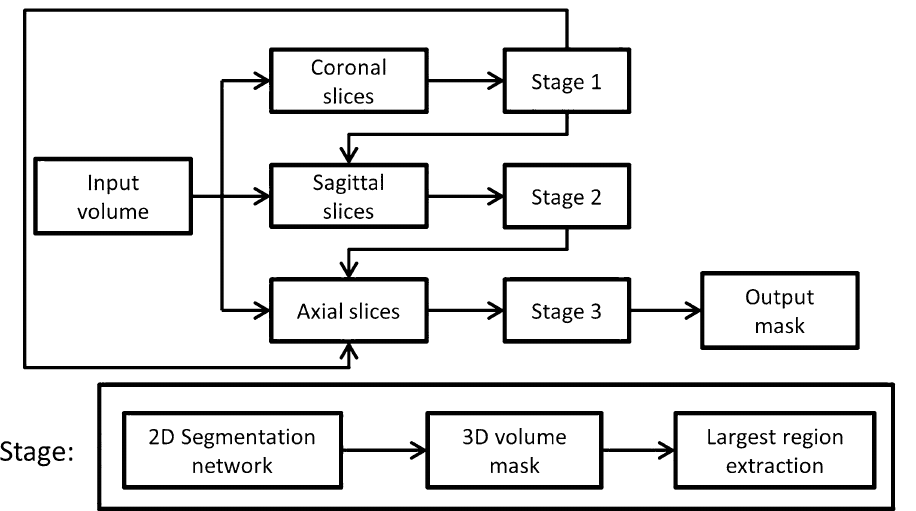
Figure 2. Workflow of the proposed framework. The framework is compatible with any 2D segmentation architecture. In this article, the following 2D segmentation networks were used: U-Net, Residual U-Net and